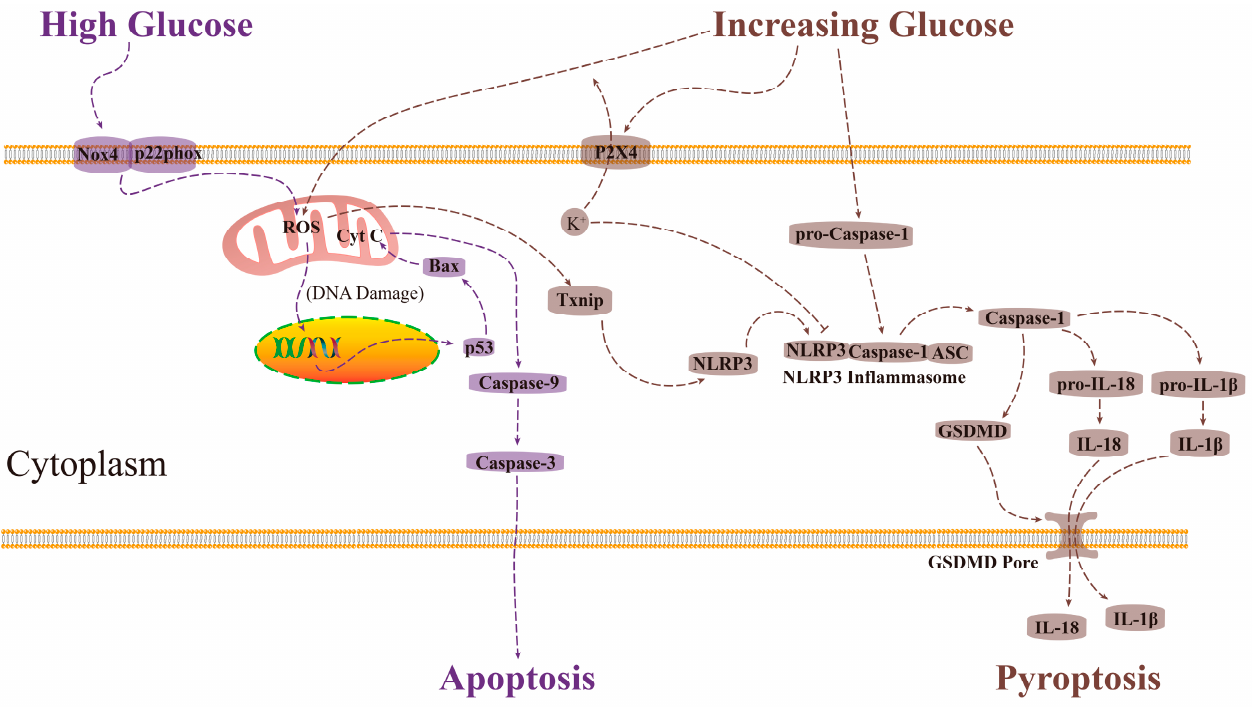
Figure 7. The sketch map of abnormal glucose-induced MDBK cell injury. High glucose increased the level of Nox4 protein in the cell membrane, which elevated the ROS level in the mitochondria. The elevated ROS damaged the DNA, activating the p53 protein. The p53 protein induced the assembly of Bax protein in the mitochondrial membrane, releasing the Cyt C protein, which triggered the downstream proteins caspase-9 and caspase-3, resulting in apoptosis. Increasing glucose elevated the ROS level in the mitochondria, which activated the Txnip protein and then activated the NLRP3 protein. Increased glucose also increased the level of P2X4 protein in the cell membrane, resulting in the decrease of the concentration of intracellular K + , which inhibited the activation of the NLRP3 inflammasome. Increasing high glucose also increased the level of pro-caspase-1, which participated in the assembly of the NLRP3 inflammasome. The released caspase-1 protein from the NLRP3 inflammasome promoted the self-splicing of GSDMD protein, pro-IL-I8, and pro-IL-1 β . The GSDMD-N formatted a non-selective protein pore, which allowed the efflux of the mature IL-18 and IL-1 β , resulting in cell pyroptosis and aggressive inflammatory response.